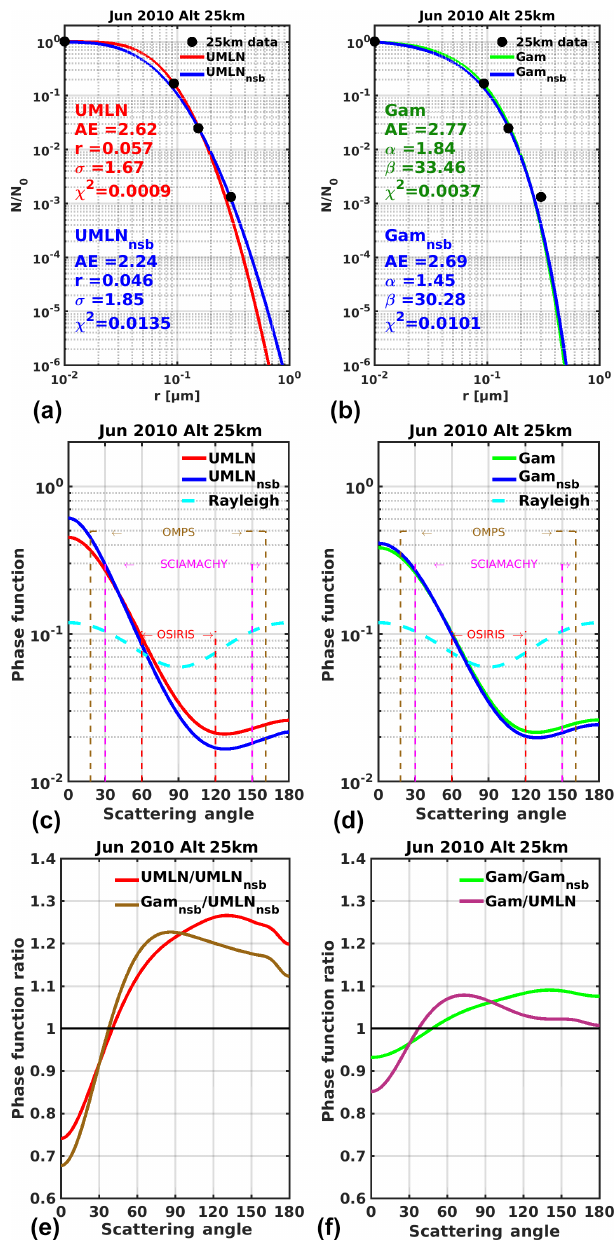
Figure 6. Unimodal lognormal distribution fits (a) and gamma dis- tribution (b) fits to June 2010 data for altitude 25km. Blue lines indicate fits nsb made without the 0.094µm measurement, while the red line fit includes all measurements as before (compare with Fig. 1). Panels (c) and (d) are the phase functions derived at 675nm wavelength from the parameters of the fits. The range of scattering angles observed by OMPS, SCIAMACHY, and OSIRIS for which aerosol extinction retrievals are performed is also indicated on these figures. Panels (d) and (e) show the ratios of the phase functions of the different